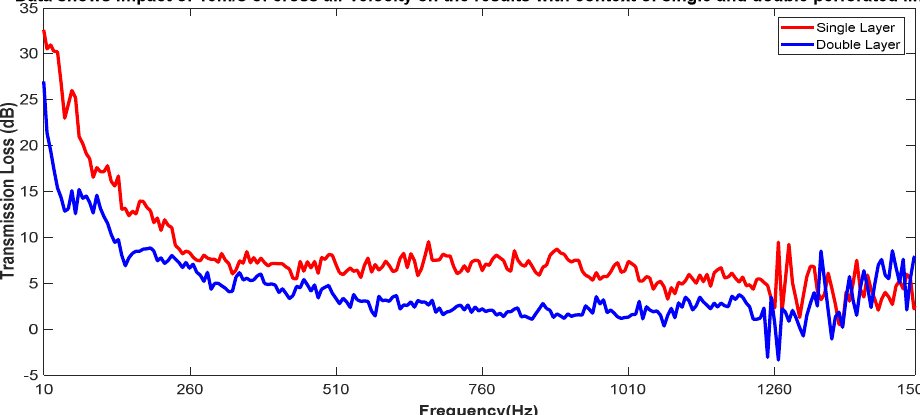
Fig. 5. The acoustic transmission loss versus frequency. The data were collected with air cross-velocity equal to (10m/s) using the perforated liners.